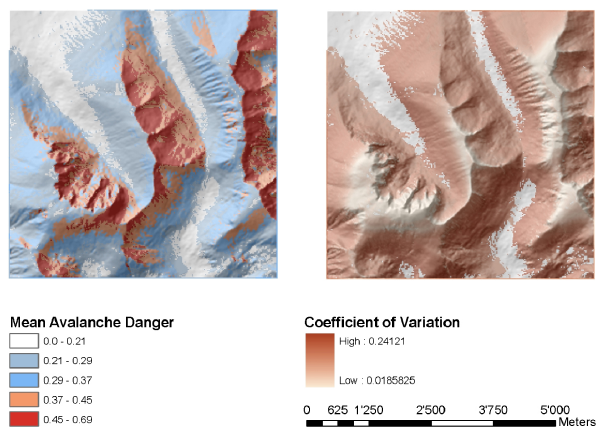
Fig. 7. Ensemble mean (left) and prediction uncertainty as a coefficient of variation of ensemble predictions (right) on 15 February